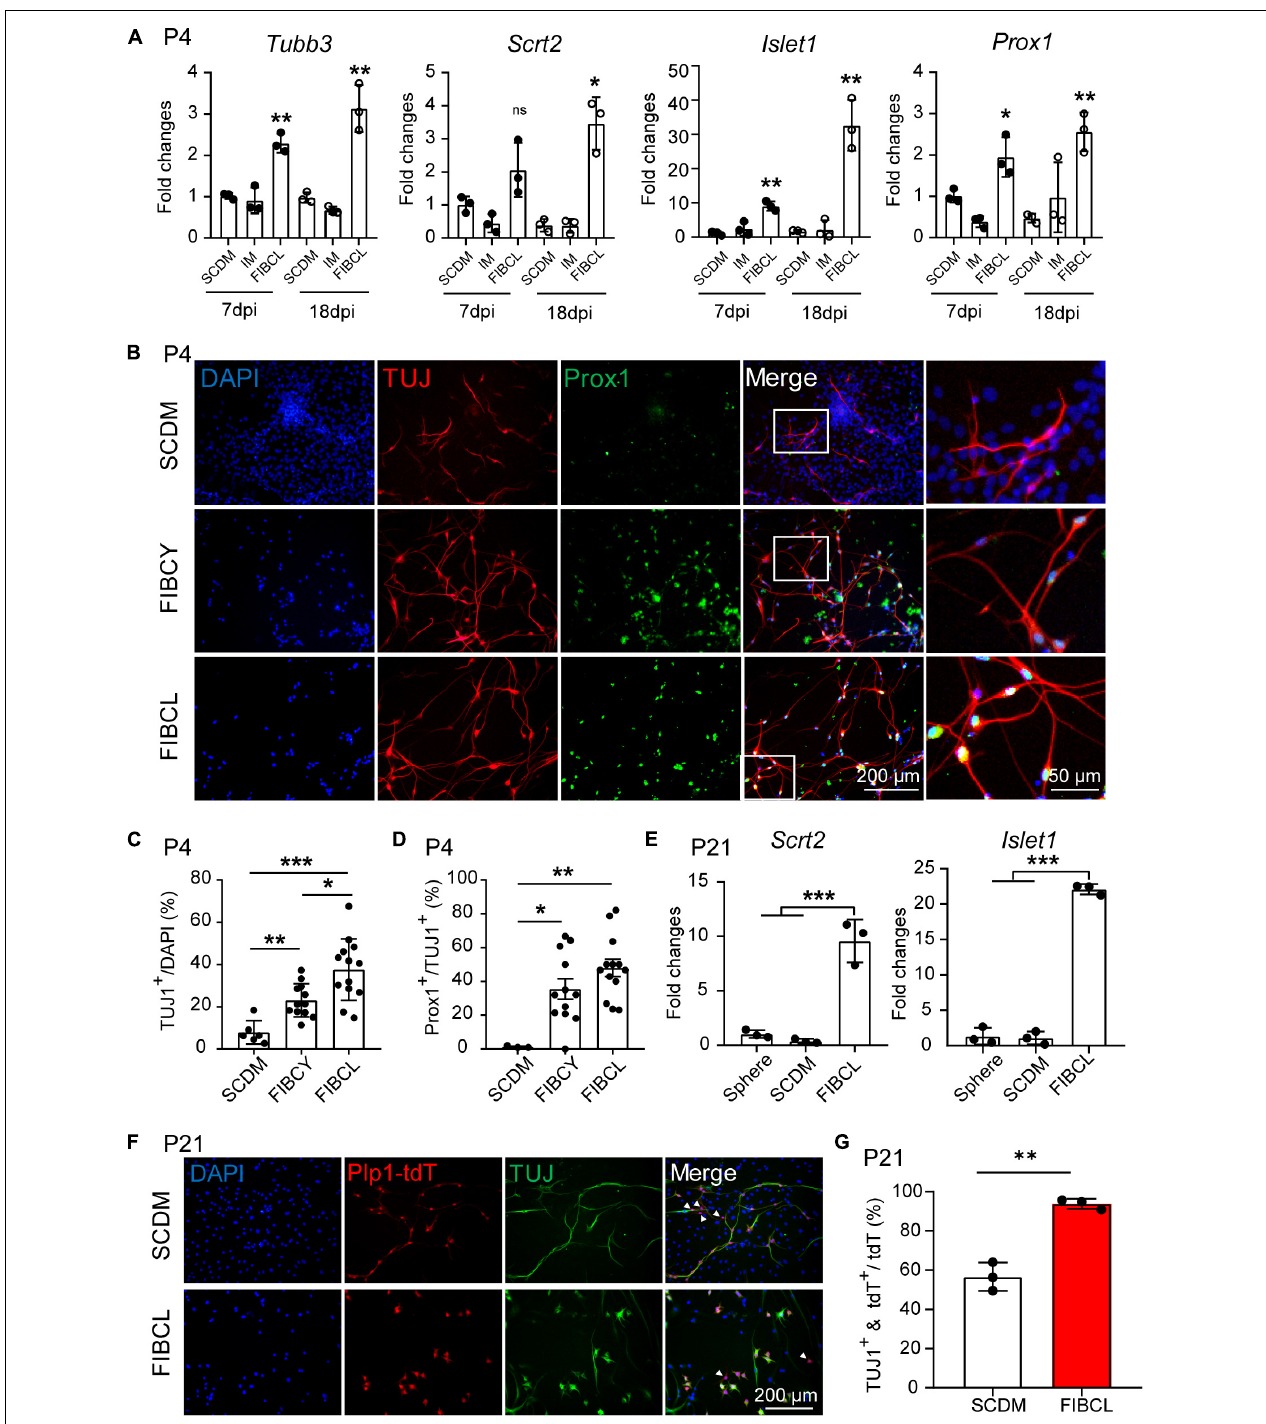
FIGURE 7 | Small molecules promote neuronal differentiation and maturation of cochlear glial cells. (A) RT-qPCR gene expression analyses of P4 cochlear glial cells differentiated in SCDM, IM or FIBCL at 7 and 18 div. FIBCL, Forskolin, ISX9, I-BET151, CHIR99021, and LIF. N = 3, error bars represent mean ± SD. (B) Immunocytochemical stainings of TUJ1 and Prox1 in neurons induced from P4 cochlear glial cells at different conditions. (C,D) Percentages of TUJ1 positive cells (C) and TUJ1/Prox1 double positive cells (D) differentiated in SCDM, FIBCY, or FIBCL. N = 3–13 images from 2 wells of each condition, error bars represent mean ± SD. (E) mRNA expression of SGN markers Scrt2 and Islet1 . N = 3, error bars represent mean ± SD. (F) Immunocytochemical staining of TUJ1 of induced neurons from P21 Plp1-tdT cochlear glial cells. The white arrowheads represent the Plp1-tdT + /TUJ1 − cells. (G) Percentages of TUJ1 positive cells differentiated from P21 Plp1-tdT + cochlear glial cells. N = 3, error bars represent mean ± SD. * p < 0.05, ** p < 0.01, *** p < 0.001 by one-way ANOVA (A,C–E) or unpaired student’s t -test (G) .